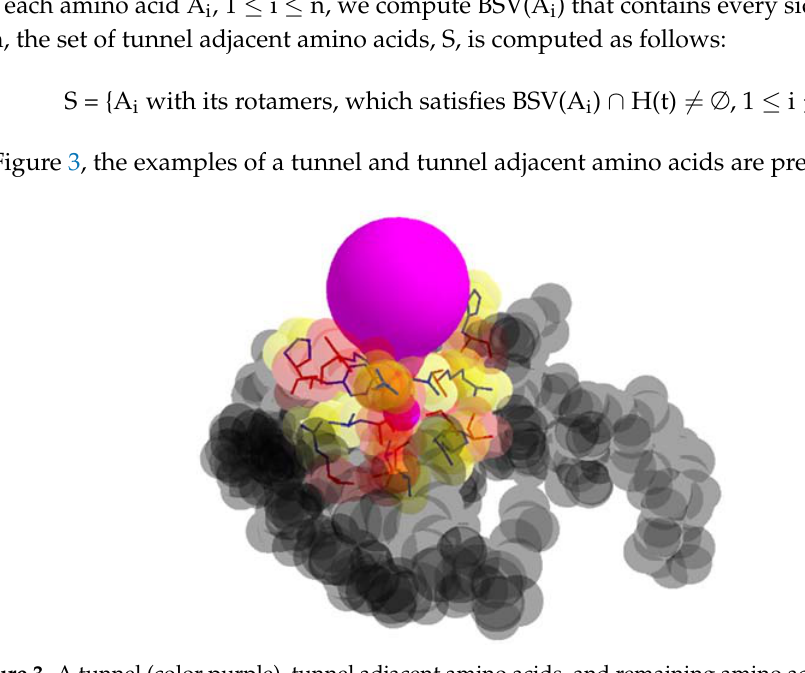
Figure 4. Collisions between rotamers ( left ) and the corresponding collision free graph ( right ).